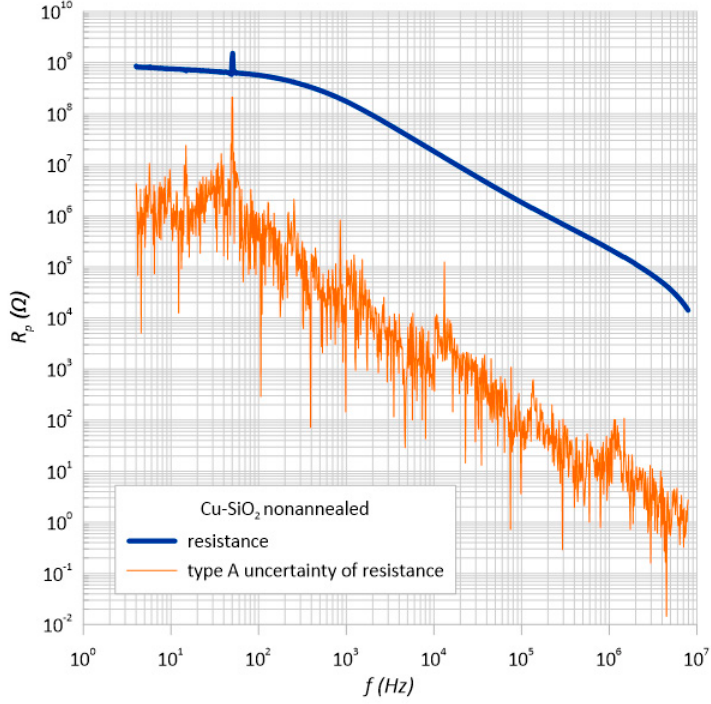
Figure 9. Frequency dependence of the resistance R p and its estimator u ( R p ) measured at room temperature immediately after the preparation process.